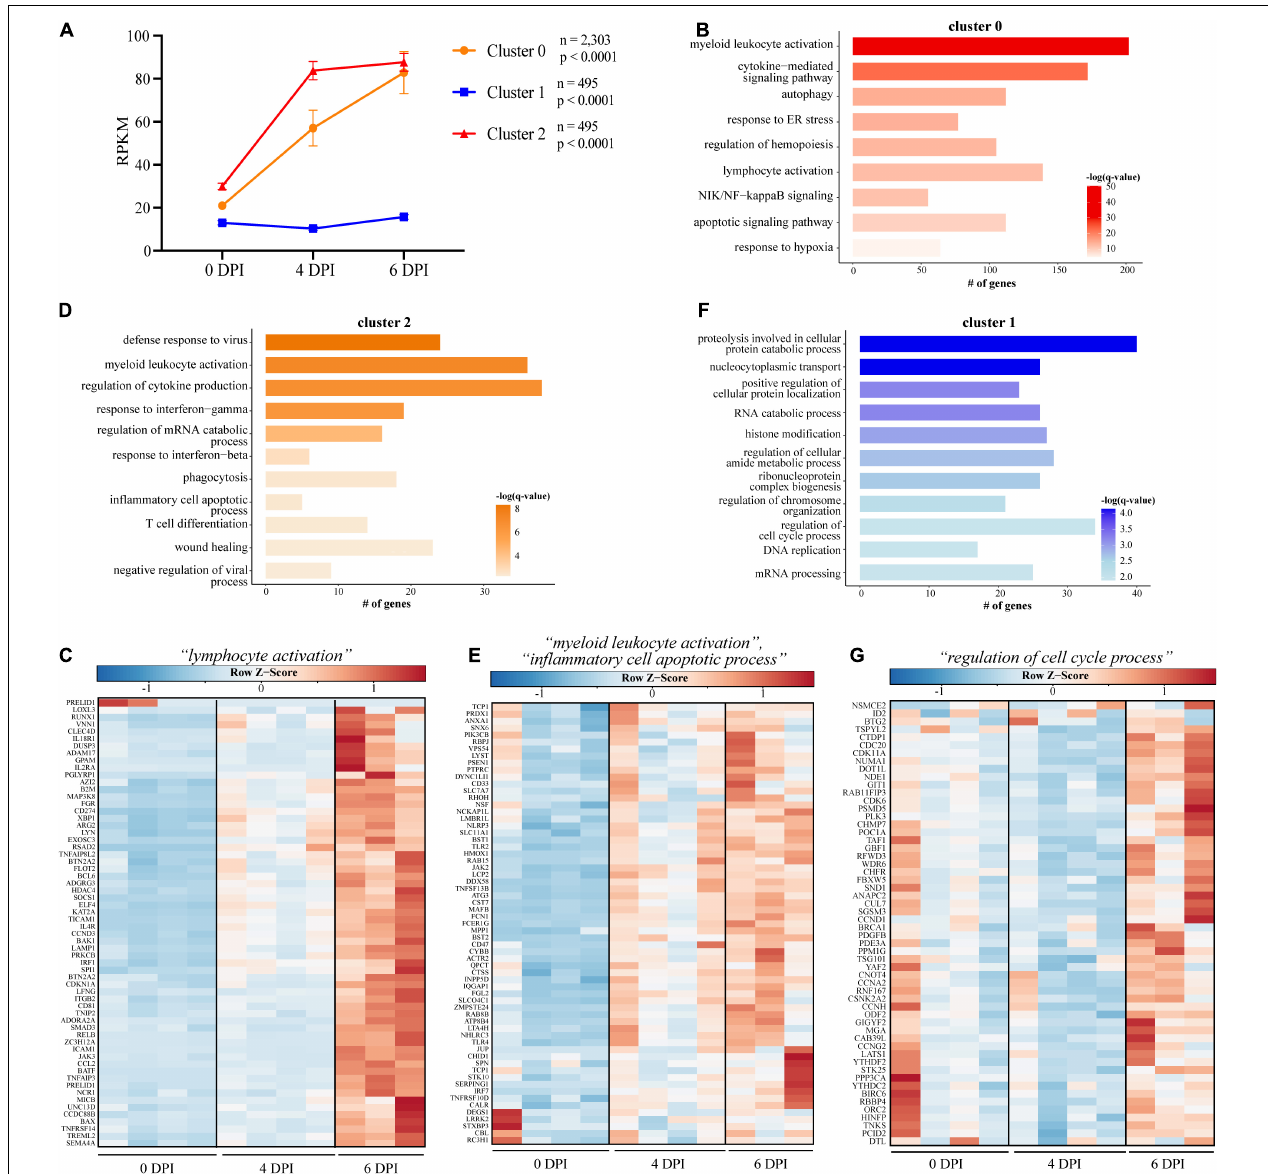
FIGURE 2 | Short Time Series Expression Miner (STEM) analysis of gene expression data following EBOV-Mayinga infection. (A) Gene expression clusters identified by STEM with accompany number ( n ) of genes and p -value ( p ). GO term bar graphs representing functional enrichment of the genes from (B) cluster 0, (D) cluster 2, and (F) cluster 1. Horizontal bars represent the number of genes mapping to each GO term, while color intensity represents the –log( q -value) value of the corresponding GO term. Gene expression heatmaps depicting genes from GO term (C) “lymphocyte activation” in cluster 0, (E) “myeloid leukocyte activation” and “inflammatory cell apoptotic process” in cluster 2, and (G) “regulation of cell cycle process” from cluster 1. Each column represents one animal. Red represents upregulation; blue, downregulation. Range of colors is based on scaled and centered rpkm values of the represented DEGs.